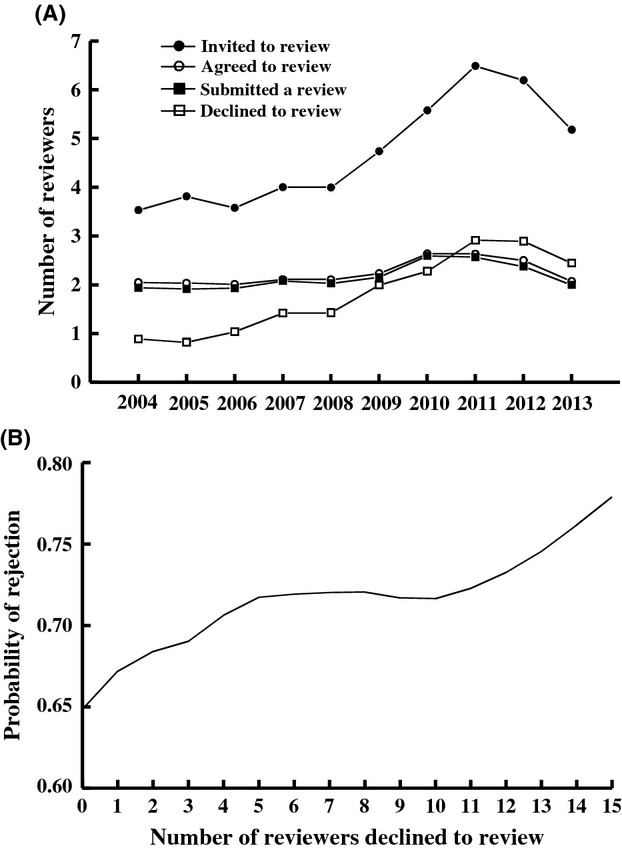
(A) The number of reviewers invited, agreed to review, submitting a review, and declining to review from 2004 to 2013. Note that Functional Ecology editors have had to invite increasingly more reviewers to obtain approximately the same number of reviews (two per paper) over the course of the 10-year period. (B) Cubic spline fit (with binomial data) for the probability of rejection versus the number of reviewers that declined to review a manuscript. The analysis controls for the effect Submission Year.